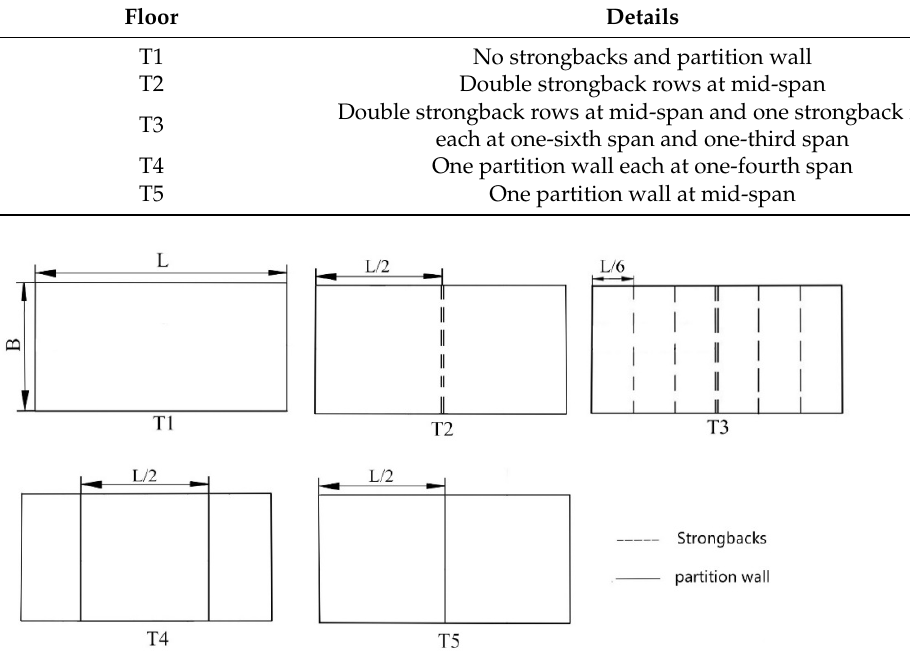
Table 1. Details of test floor structures.